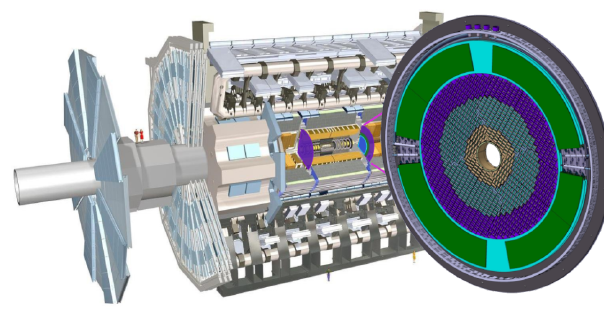
Fig. 1: Position of the HGTD within the ATLAS Detector [3].